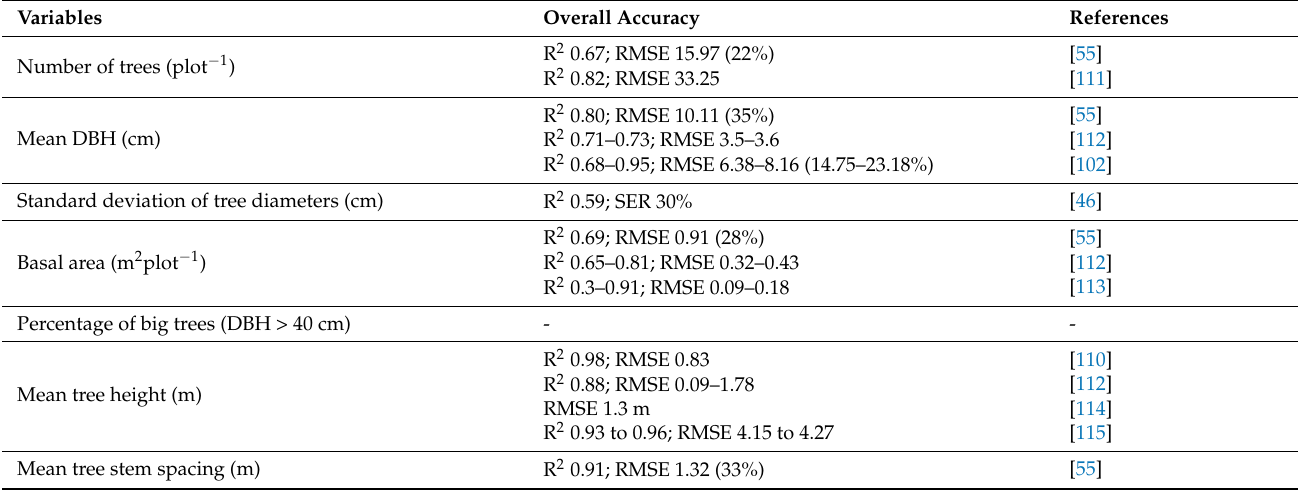
Table 7. Statistics (root mean square error (RMSE), normalised RMSE (%), coefficient of determination (R 2 ) and standard error of the regressions (SER%)) from the literature for the same metrics used in the current study which were estimated using airborne laser